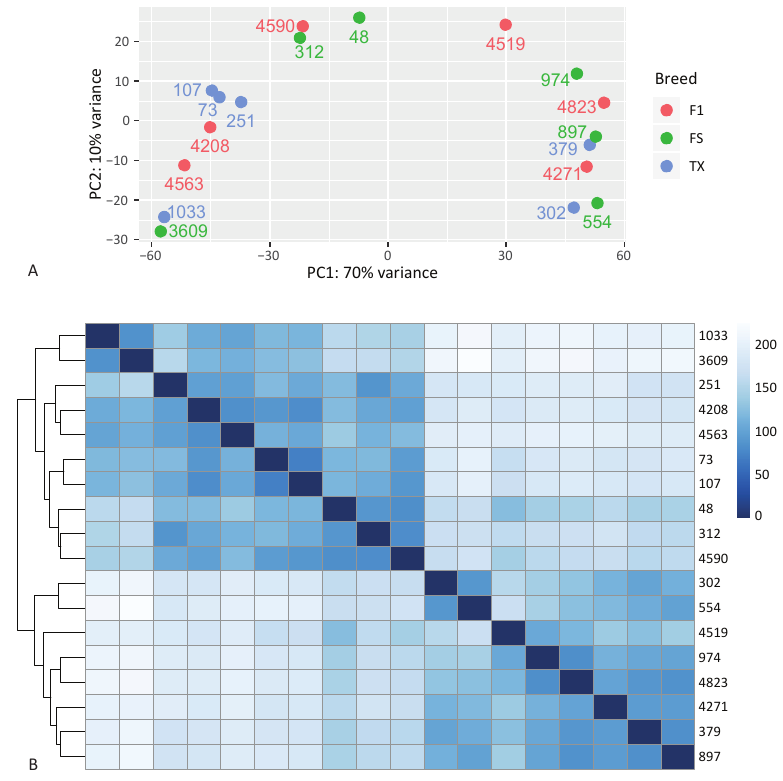
Fig. 2. Sample relatedness. (A) PCA plot of samples representing Finnsheep (FS), Texel (TX) and F1 crosses (F1) based on normalized counts. (B) Heatmap plot of sample distance